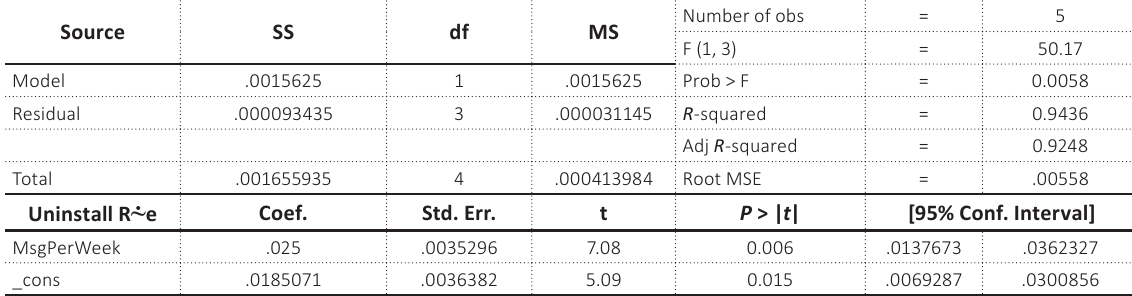
Table 3. Uninstall rate determined by frequency – regression